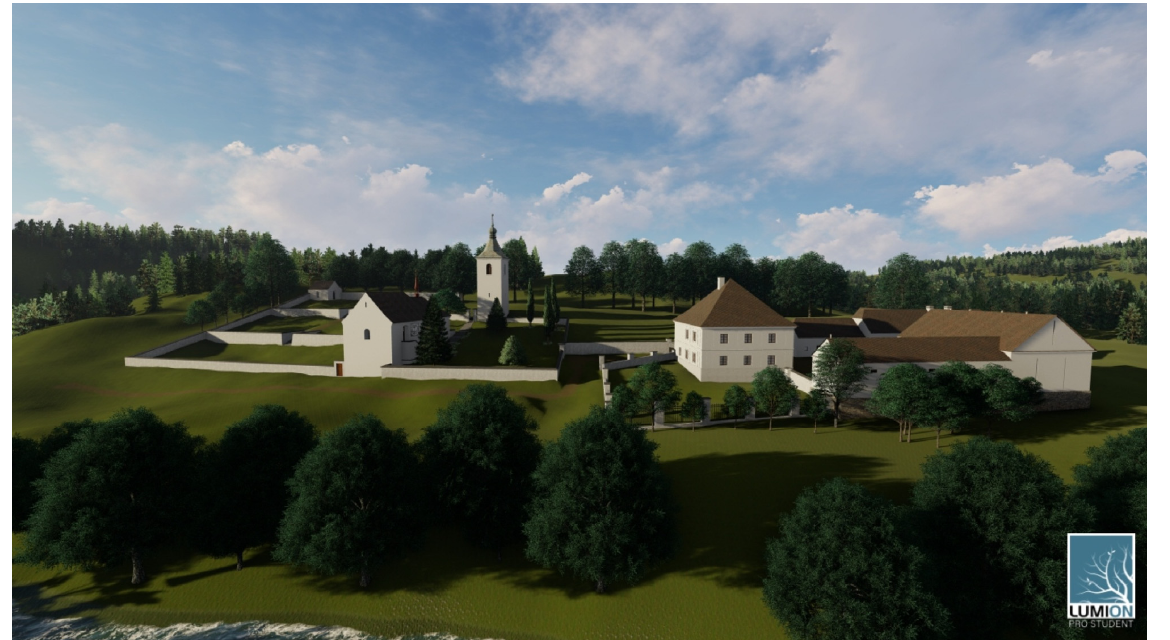
Figure 7. Parish complex in Č ervená visualized using Lumion 3D, Source: author’s elaboration.